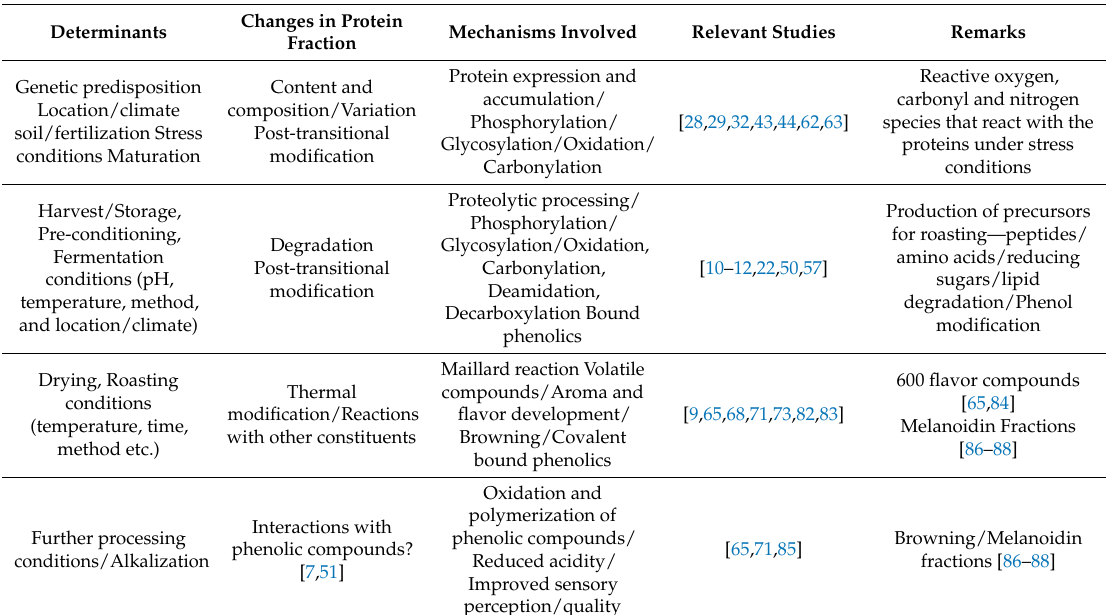
Table 1. Dominant reported and postulated changes in the protein fractions during the seed maturation and post-harvest